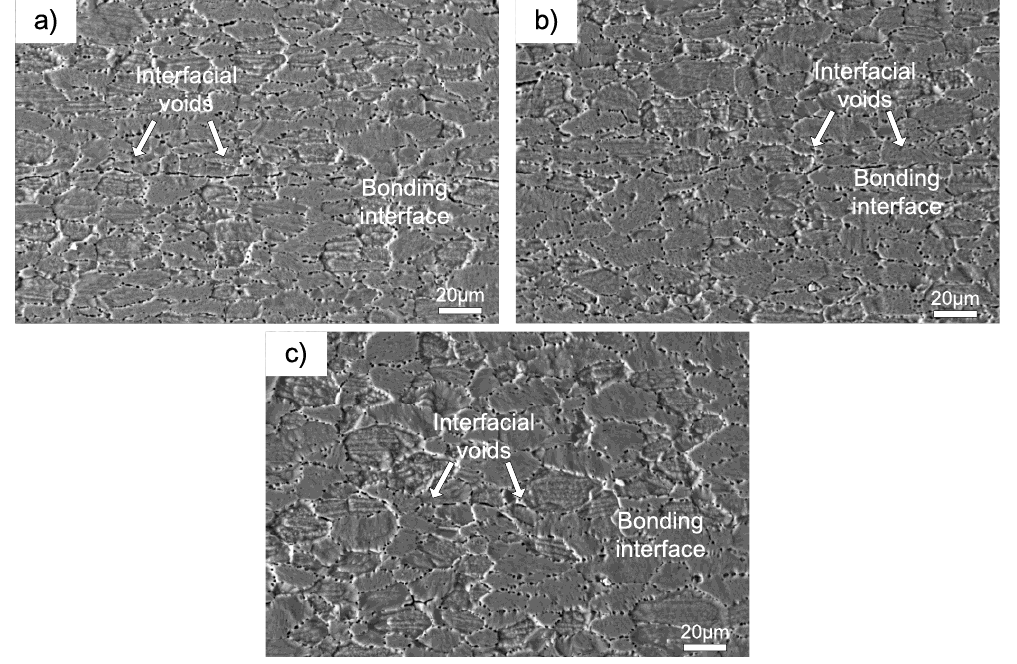
Figure 5. SEM micrographs of the 7B04-7B04 interface microstructure at different temperatures: ( a ) 460 °C; ( b ) 490 °C; ( c ) 520 °C.